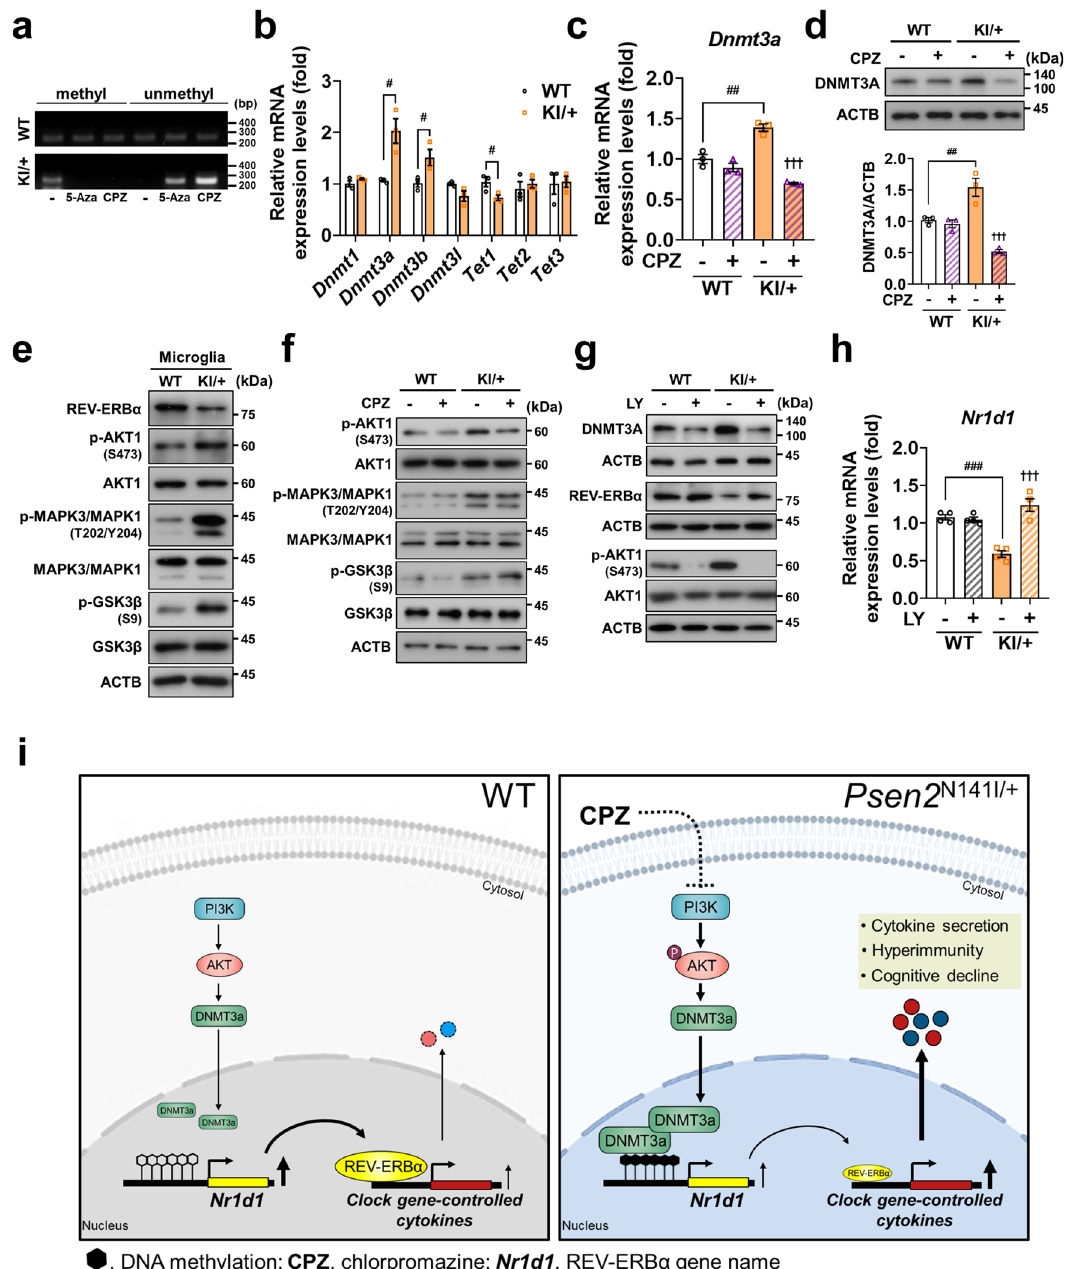
Fig. 10 Chlorpromazine recovers REV-ERB α level by rectifying hypermethylation of the Nr1d1 promoter through the inhibition of PI3K/AKT1 pathway in Psen2 N141I KI/ + microglia. a Methylation-speci fi c PCR analysis on Nr1d1 promoter of KI/ + microglia after CPZ (0.5 μ M) treatment for 12 h. 5-Aza (10 μ M) as a positive control was treated for 24 h. Genomic DNA extracted from microglia was conversed using bisul fi te administration. The agarose gel image is representative of three independent experiments with similar results. b Comparison of relative mRNA expression levels of DNA (de)methylases between WT and KI/ + primary microglia ( n = 3) (WT vs KI/ + : # p = 0.0161, # p = 0.0447, and # p = 0.0459; unpaired t -test). c , d Relative Dnmt3a mRNA ( c ; n = 3) and protein levels ( d ; n = 3) after CPZ treatment for 12 h in WT and KI/ + microglia (untreated WT vs untreated KI/ + : ## p = 0.0013 and ## p = 0.0083; untreated KI/ + vs CPZ-treated KI/ + : ††† p < 0.0001; one-way ANOVA). e Western blotting analyses of the phosphorylation levels of AKT1 at S473, MAPK1/3 at T202/Y204, and GSK3 β at S9 in WT and KI/ + microglia. f CPZ inhibits PI3K/AKT pathway, but not MAPK1/3 or GSK3 β . Cells were analyzed after CPZ (0.5 μ M) treatment for 12 h. g LY (LY294002, 20 μ M) inhibits PI3K/AKT pathway and downregulates DNMT3A leading to the restoration of REV-ERB α levels. The blots shown are representative of three experiments with similar results. h Relative Nr1d1 mRNA expression levels after LY treatment for 12 h in WT and KI/ + microglia ( n = 4). mRNA levels were normalized to 18s rRNA ( b , c , h ). i Schematic diagram suggesting hyperactive immune responses caused by the Psen2 N141I mutation. The mutation activates PI3K/AKT pathway and upregulates DNMTs, which induces the epigenetic suppression of REV-ERB α and hyperactive immune response in innate immune cells. An antipsychotic, CPZ, rescues REV-ERB α expression by DNA demethylation through the inhibition of PI3K/AKT1 pathway, and prevents hyperimmunity and cognitive decline in Psen2 N141I/ + mice. Data are mean ± SEM. ††† p < 0.001 vs untreated KI/ + control. # p < 0.05, ## p < 0.01, and ### p < 0.001 for the indicated comparisons. Source data are provided as a Source Data fi